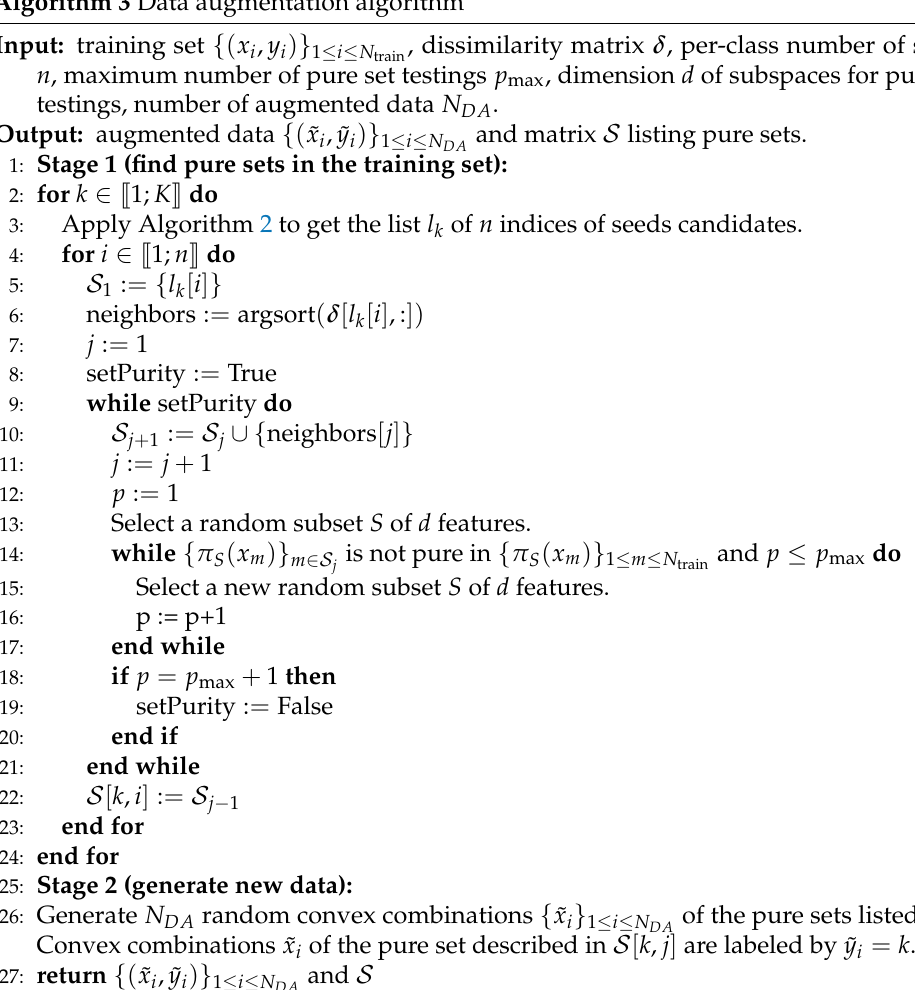
Algorithm 3 Data augmentation